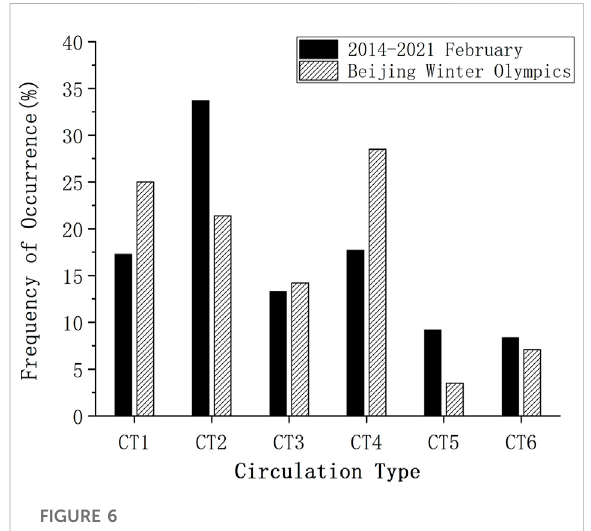
FIGURE 6 Comparison of the frequency of the six circulation patterns during the 2022 Beijing Winter Olympics and the same period in 2014 – 2021.